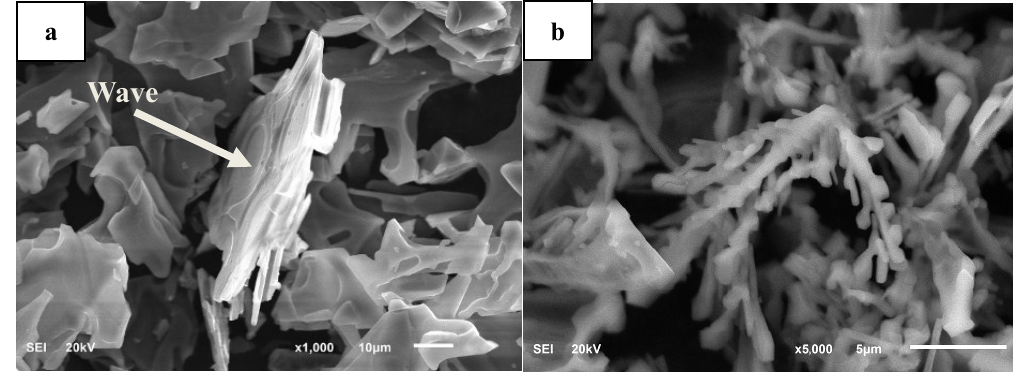
Figure 13. Morphology of eutectic Si in Al-17%Si alloy: ( a ) unmodified eutectic Si; ( b ) modified eutectic